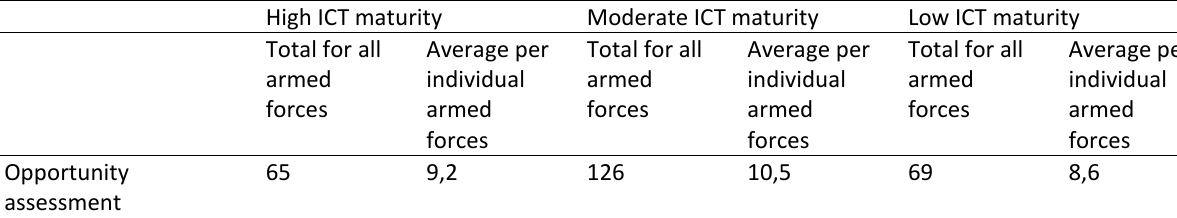
Table 5. Opportunities related to ICT maturity .